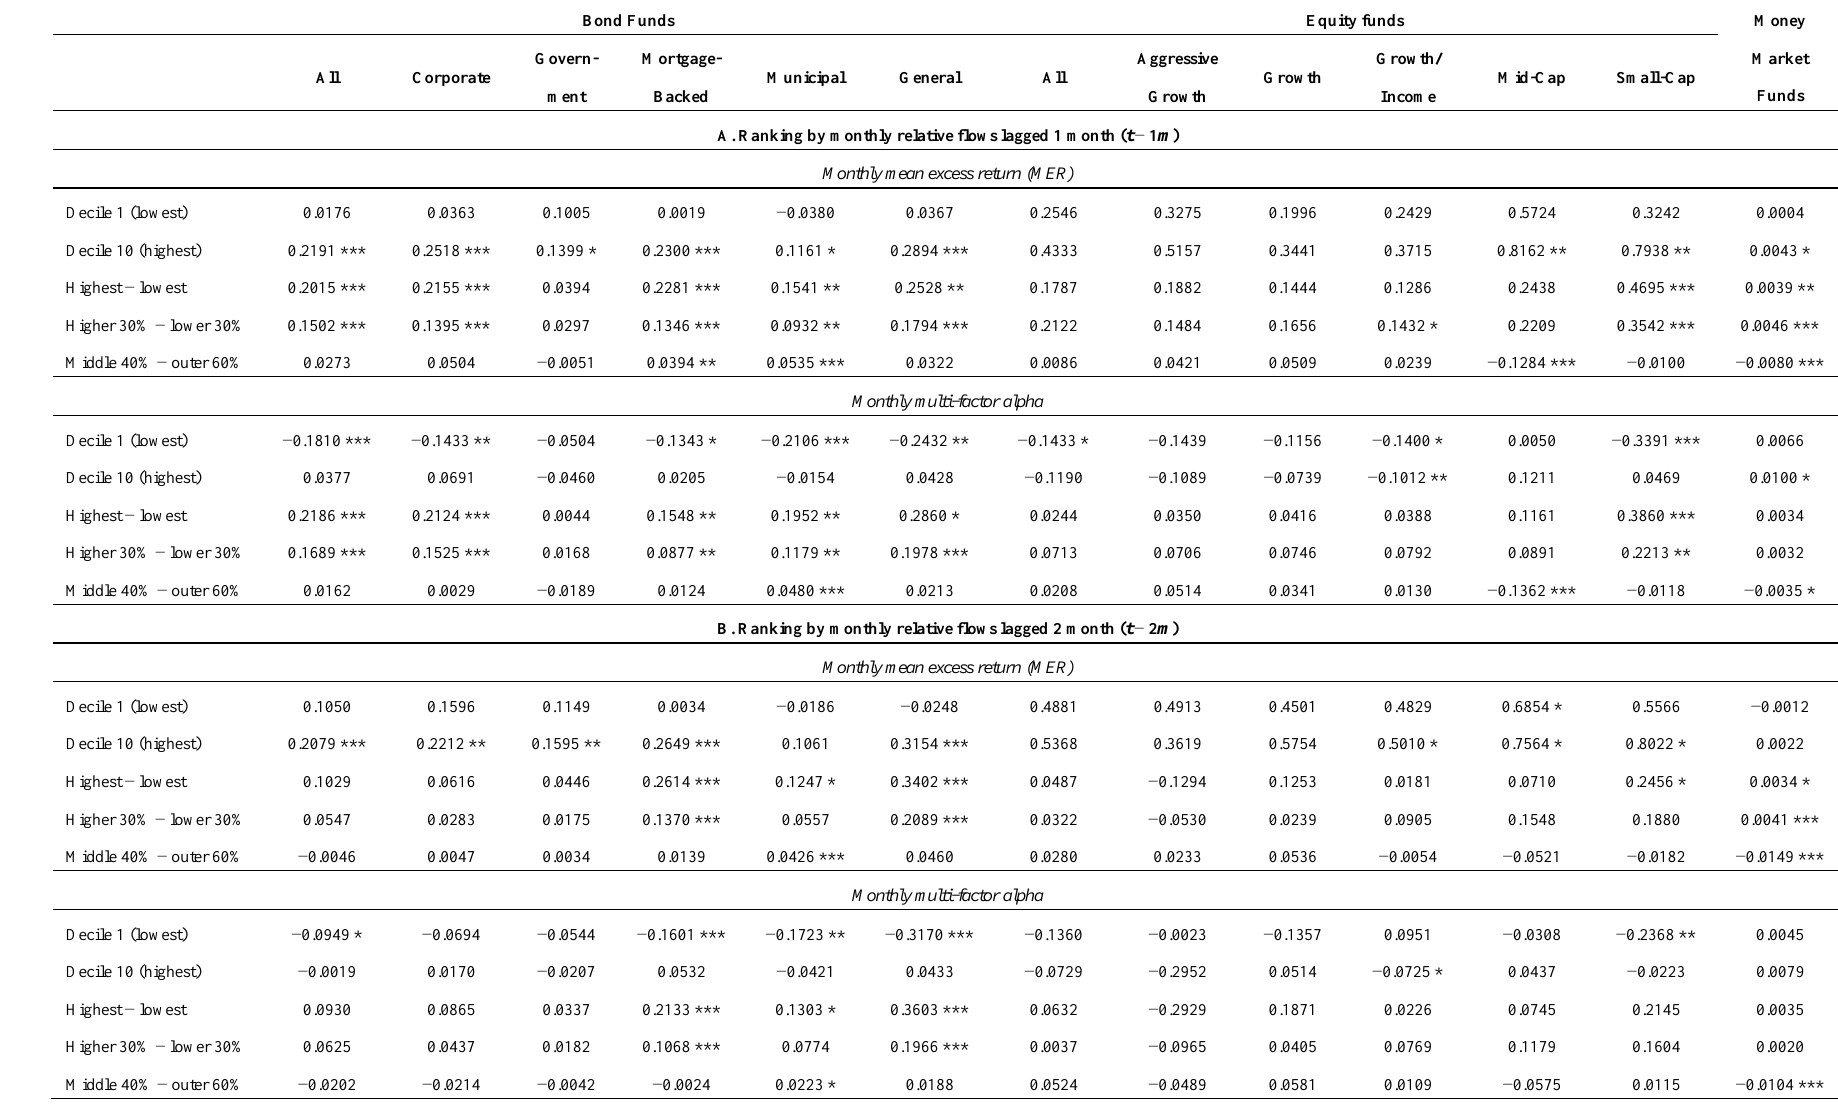
Table 6. Deciles ranked by relative